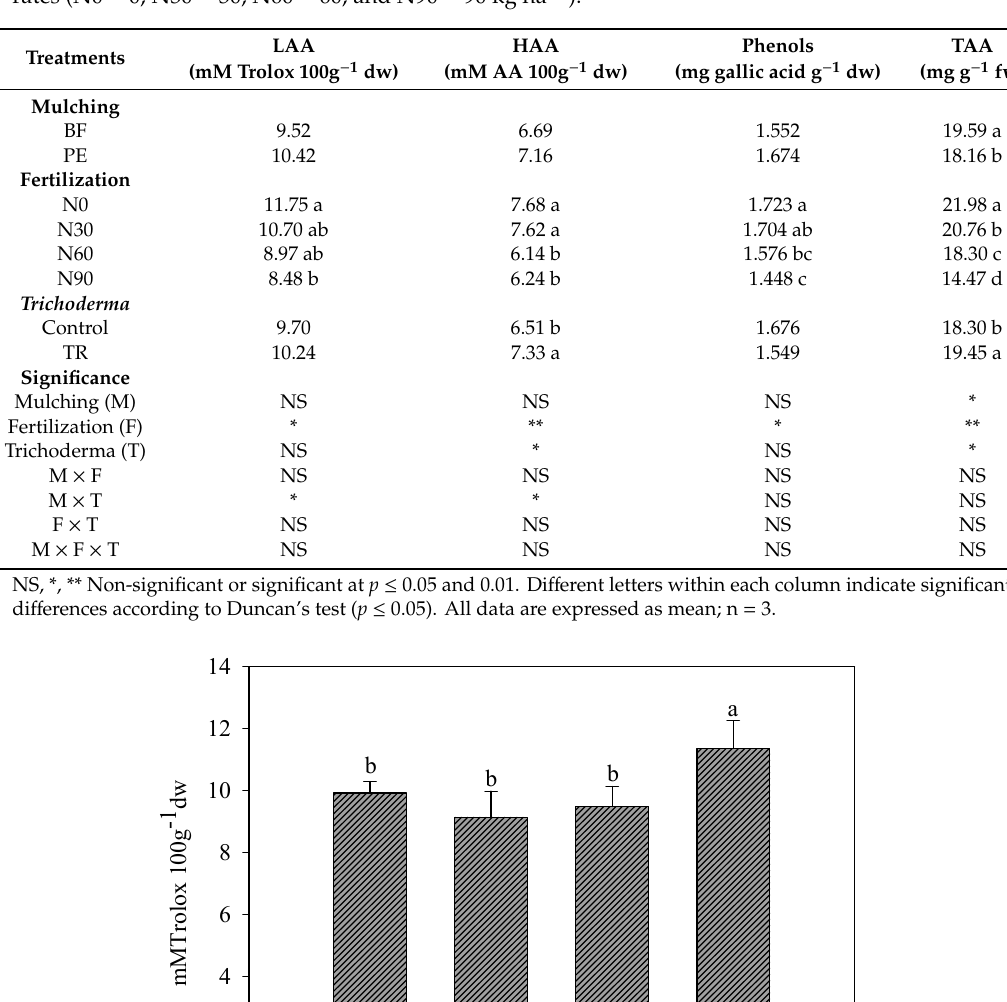
Table 3. Lipophilic (LAA) and hydrophilic (HAA) antioxidant activities, total phenols, and total ascorbic acid (TAA) in relation to mulching cover films (brown photoselective film–BF and black polyethylene–PE), Trichoderma application (untreated—Control and treated—TR) and N fertilization rates (N0 = 0, N30 = 30, N60 = 60, and N90 = 90 kg ha − 1 ).